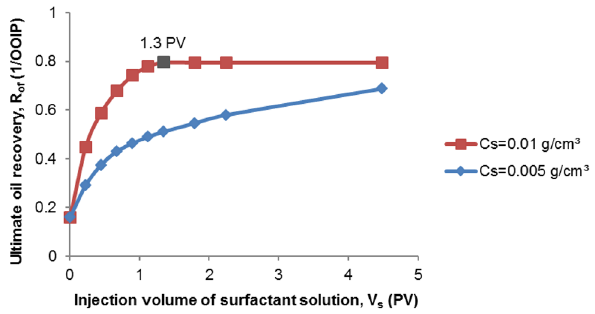
Fig. 21 The relationship between injection volume of surfactant solu- tion and the ultimate oil recovery obtained with different injection surfactant concentration